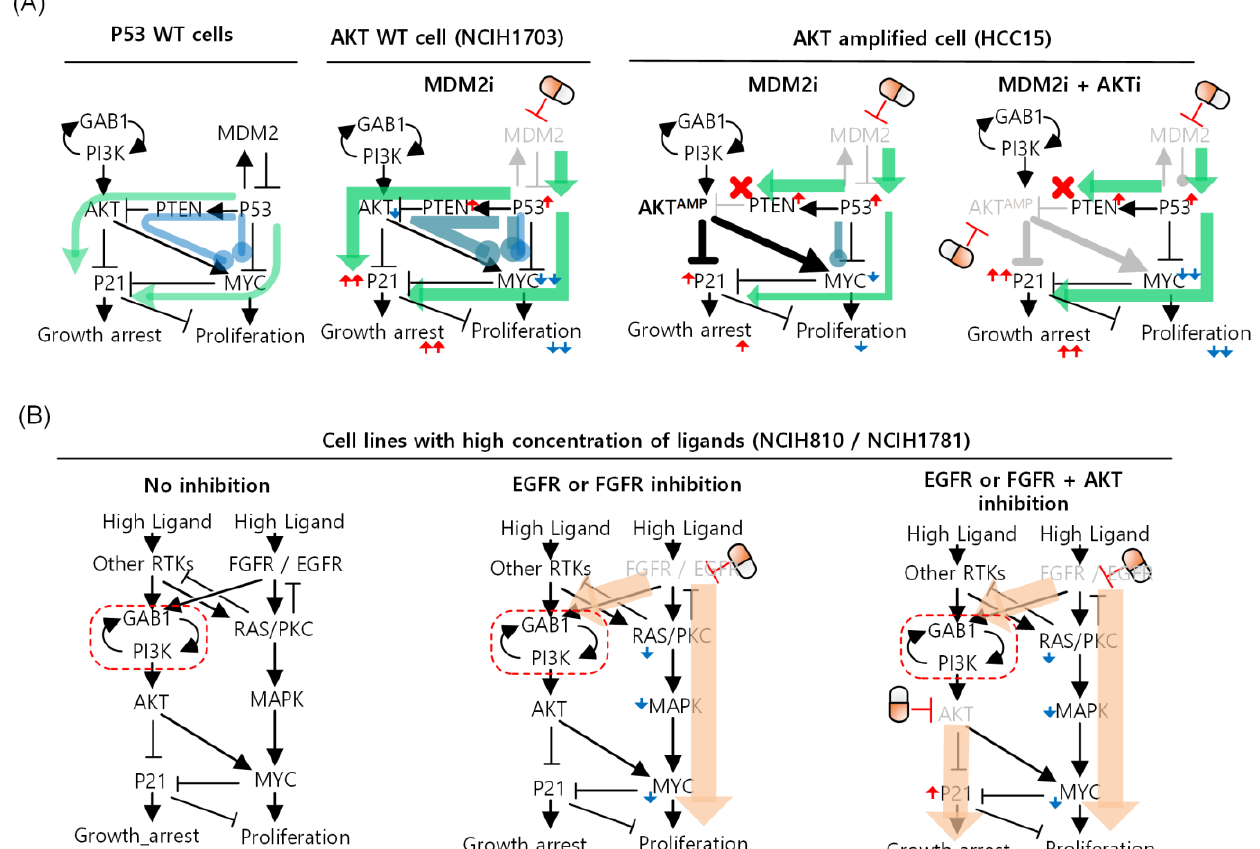
Figure 4. Identification of optimal targets specific to each resistant cell line. Identified targets and their specific mechanism in reducing proliferation and inducing growth arrest for drug sensitivity from each cell line-specific network model are shown. ( A ) MDM2 is shown as an optimal target to promote drug sensitivity in NCI-H1703 cell line. MDM2 and AKT are shown as optimal targets to promote drug sensitivity in HCC15 cell line. ( B ) EGFR and PDK1 are shown as optimal targets to promote drug sensitivity in NCI-H1781 cell line. FGFR and PDK1 are shown as optimal targets to promote drug sensitivity in NCI-H810 cell line.